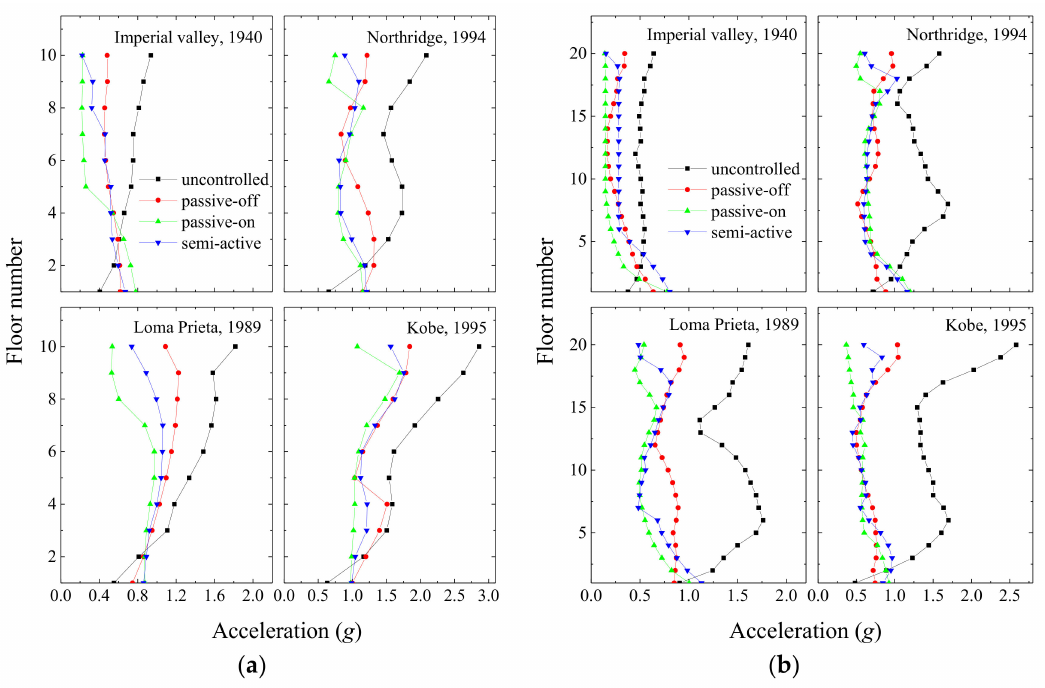
Figure 12. Peak floor acceleration under different control states in: ( a ) a coupled stiff building and